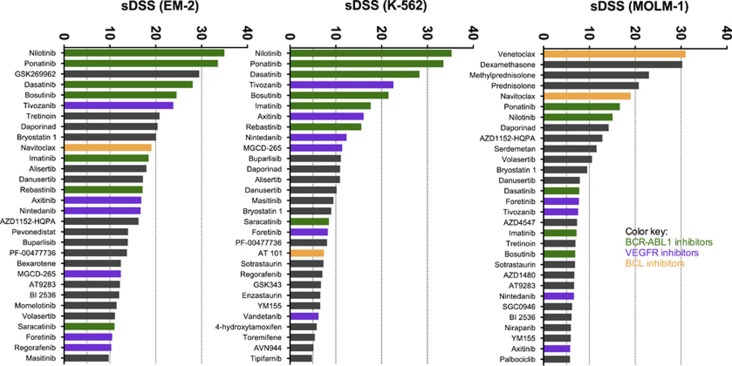
Selective DSS (sDSS) of cell lines (top 30) in descending order. Classic cytostatic and cytotoxic drugs were filtered out from graphs to focus on more targeted and novel compounds.